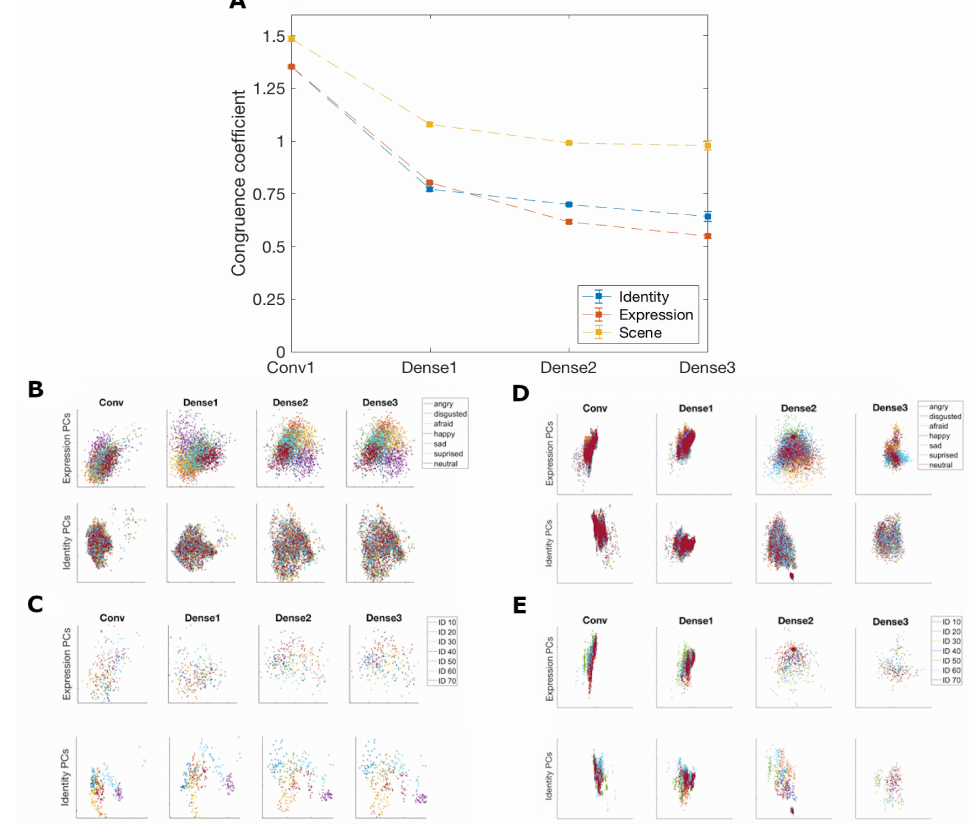
Figure 7. Trained neural networks and principal components. ( A ) Identity, expression, and scene network congruence coefficients between principal components derived from activations averaged over expression and identity. ( B ) Face activations labeled by expression projected into expression and identity principal component spaces for each layer of the identity network. ( C ) Face activations labeled by identity (only 7 of 70 identities are displayed for clarity) projected into expression and identity principal component spaces for each layer of the identity network. ( D ) Face activations labeled by expression projected into expression and identity principal component spaces for each layer of the expression network. ( E ) Face activations labeled by identity (only 7 of 70 identities are displayed for clarity) projected into expression and identity principal component spaces for each layer of the expression